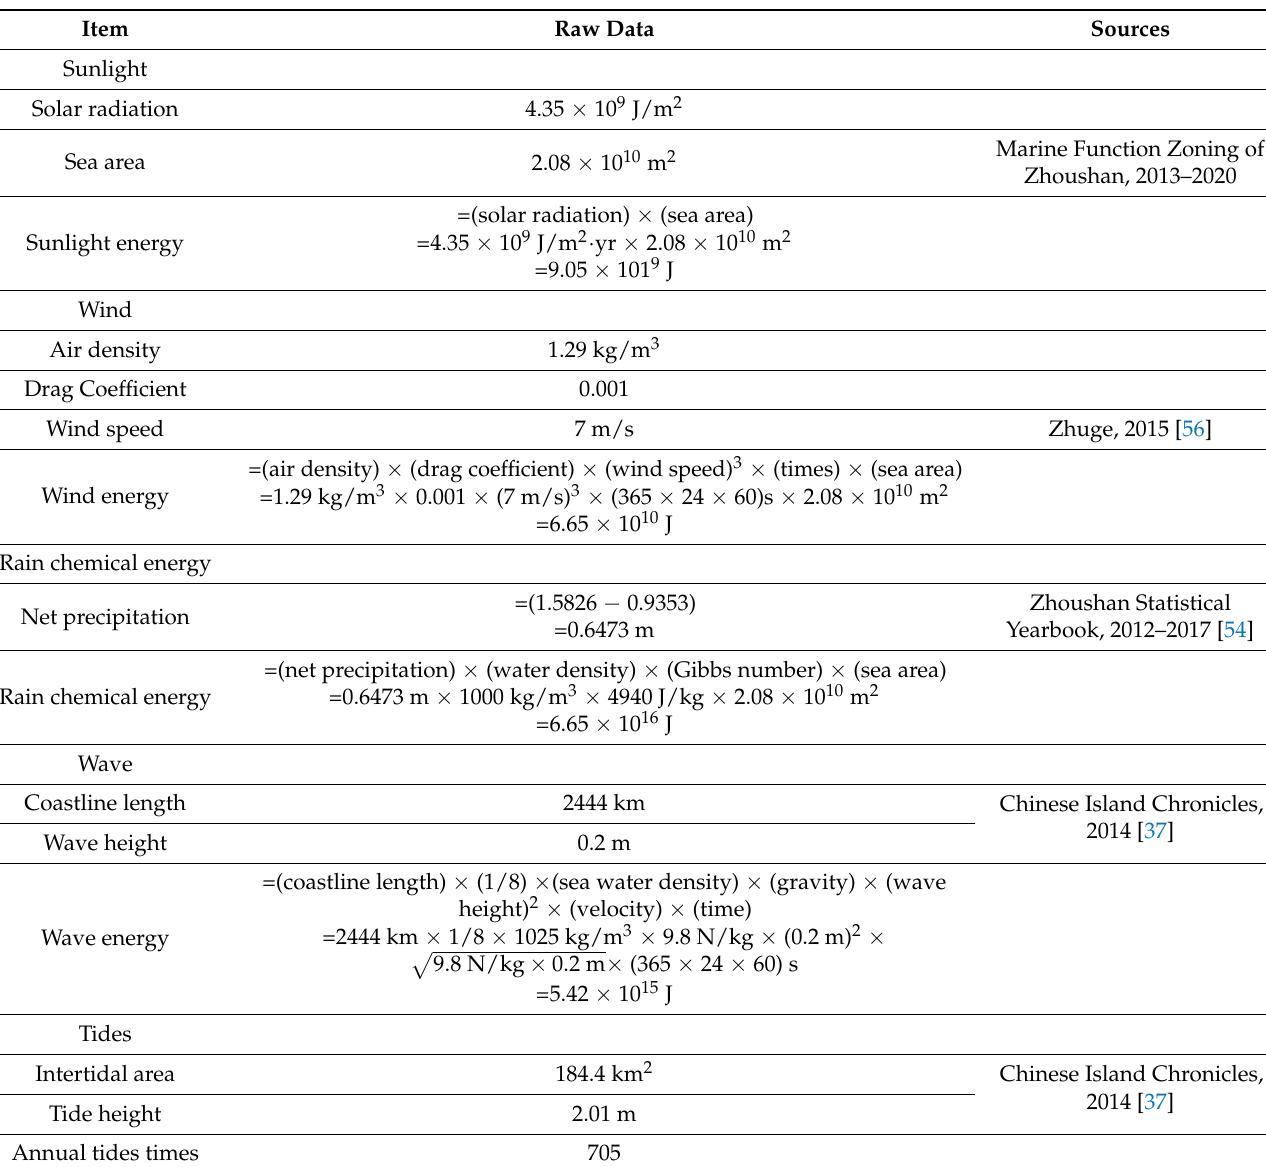
Table A1. The expression of main emergy